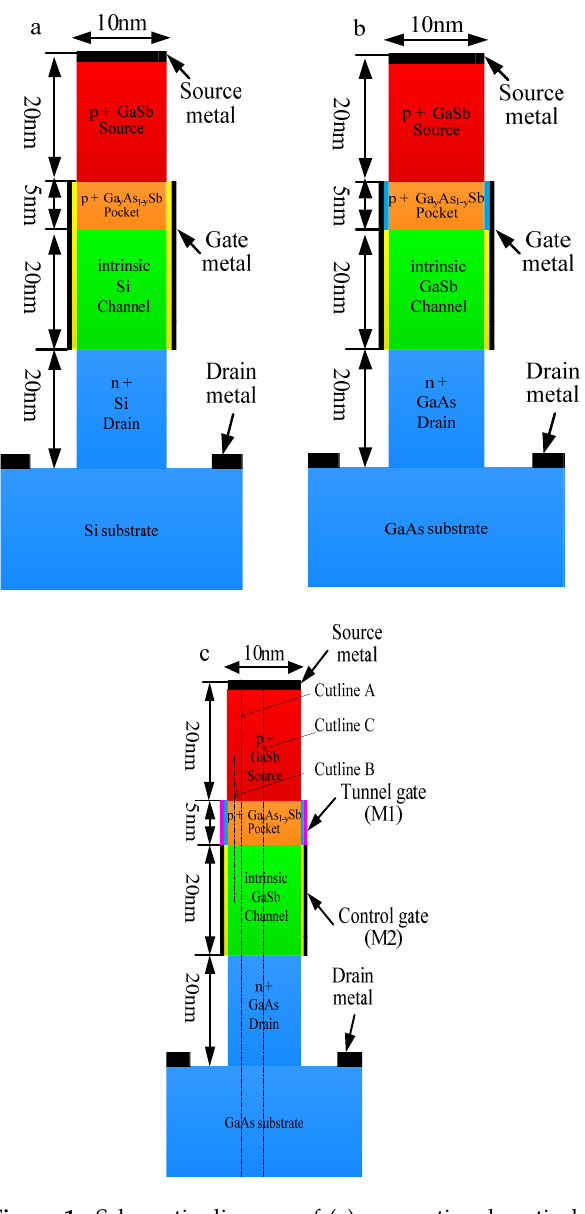
Figure 1. Schematic diagram of ( a ) conventional vertical tunnel field effect transistor (VTFET); ( b ) heterogeneous dielectric vertical TFET (HD-VTFET); and ( c ) dual material gate heterogeneous dielectric vertical TFET (DMG-HD-VTFET). Table 1. The fundamental geometrical and physical parameters of the different devices [19,40].